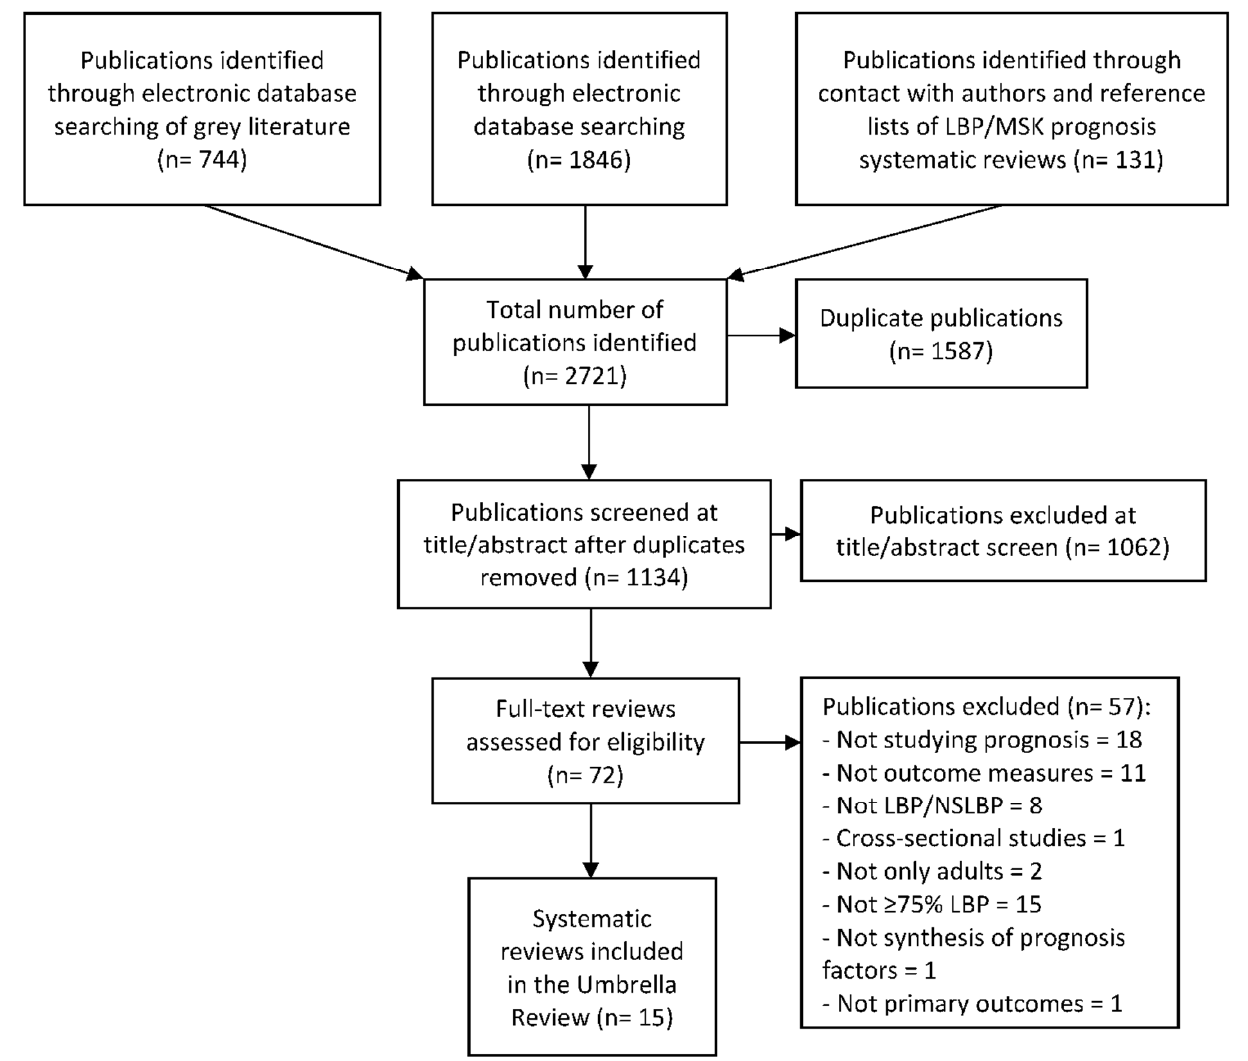
Figure 1. Flow chart of low back pain prognosis systematic reviews.